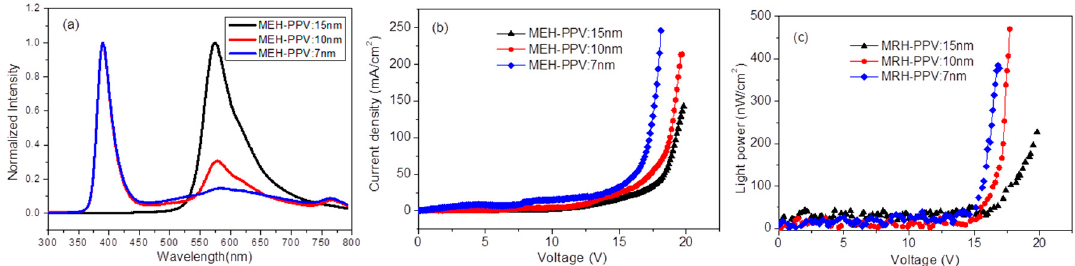
Figure 2. Electroluminescence spectra ( a ); J–V characteristics ( b ); and L–V characteristics ( c ) of three Device As with different MEH-PPV thicknesses.